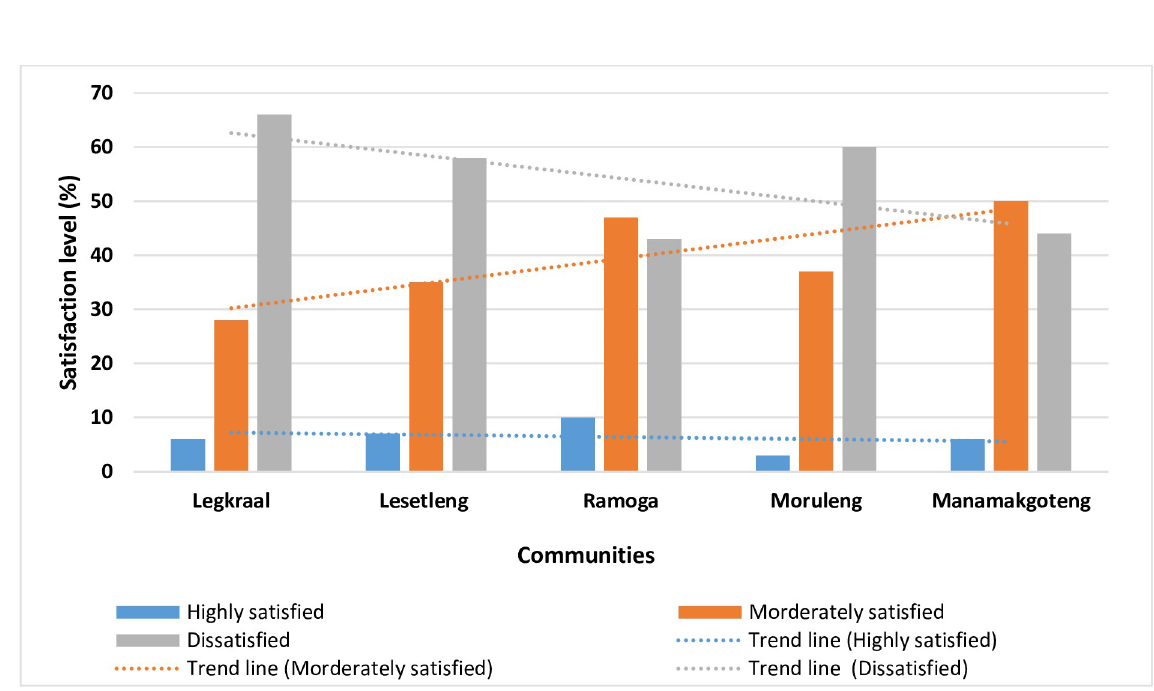
Fig 3. Patterns of satisfaction level of communities along a distance gradient (from the closest community to the furthest community away from the mining operation site).